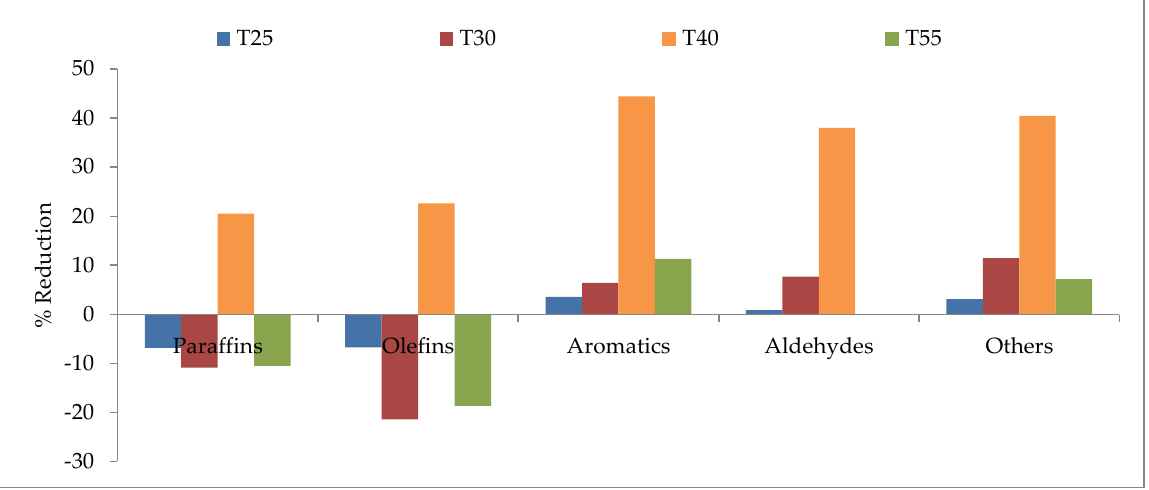
Figure 11. Reduction obtained for the different families of compounds in the gases collected in the study of the temperature (°C) at the first step of the synthesis with fixed conditions of time, 24 h, and stirring rate, 700 rpm.